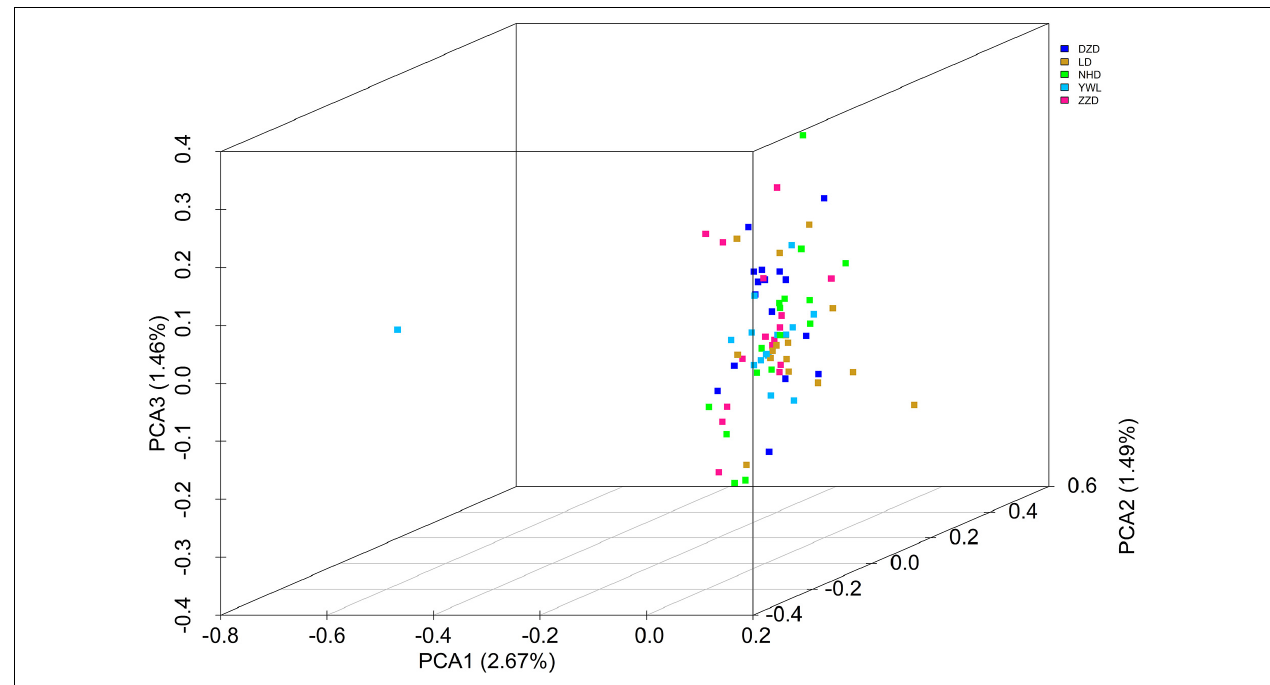
FIGURE 2 | Principal components analysis (PCA) 3D plot of the 80 individuals using genome-wide single-nucleotide polymorphisms (SNPs).